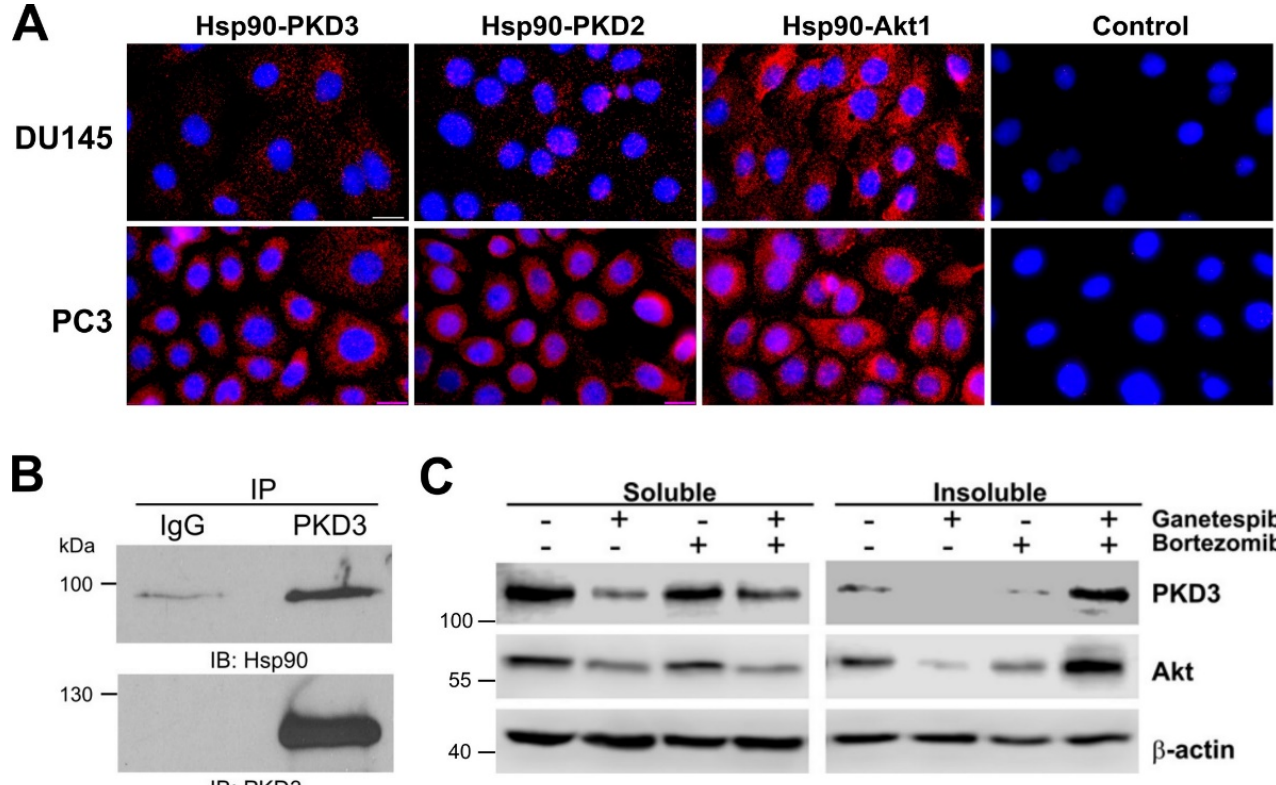
Figure 3 . Hsp90 directly interacts with PKD3 in DU145 and PC3 cells. ( A ) Cells were probed with the indicated antibodies to detect direct protein-protein interactions in situ applying PLA. Controls contained anti-mouse and anti-rabbit secondary antibodies. Scale bars represent 20 µm. ( B ) PKD3 was immunoprecipitated from PC3 cells and co-immunoprecipitated Hsp90 was analyzed by West- ern blot. ( C ) Hsp90 inhibition leads to the proteasomal degradation of PKD3. DU145 cells were treated with ganetespib or/and bortezomib as indicated for 24 h and the soluble and insoluble ly- sates were analyzed by Western blot. Images are representatives of three independent experiments.